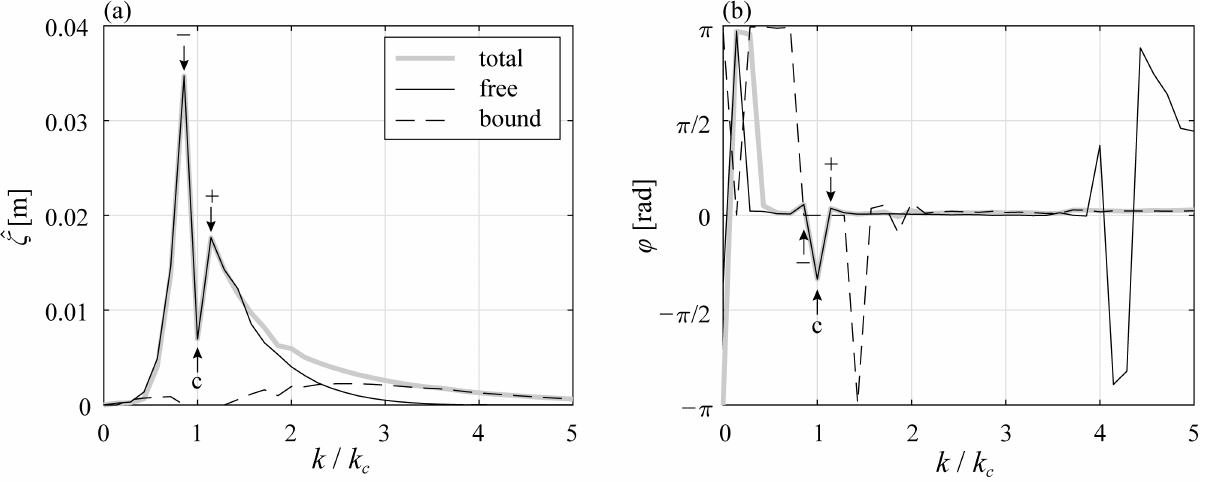
Figure 12. ( a ) Amplitude and ( b ) phase of the component waves of the modulated wave train with a 0 k c = 0.105 at the location and time of the maximum crest